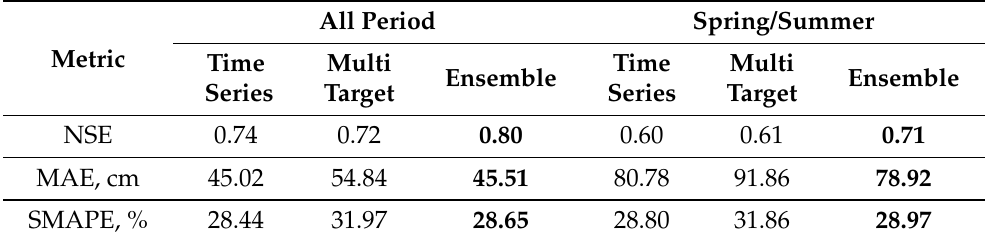
Table 5. Validation metrics for ensemble and individual machine learning models obtained for ten hydro gauges.